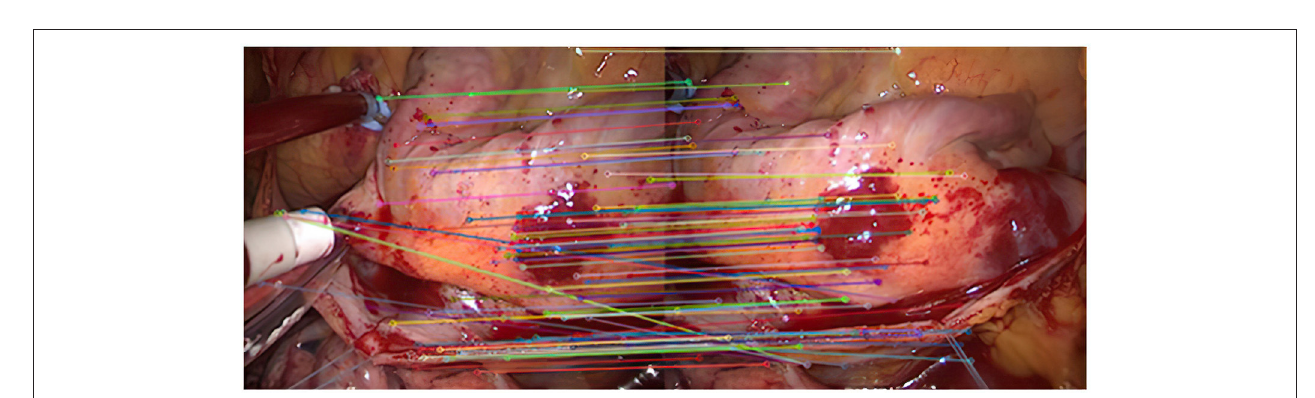
FIGURE 3 | Results of initial screening of matching pairs.